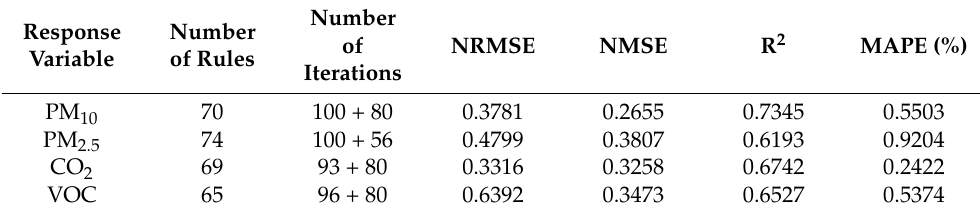
Table 9. ADFIST performance analysis with GAMS